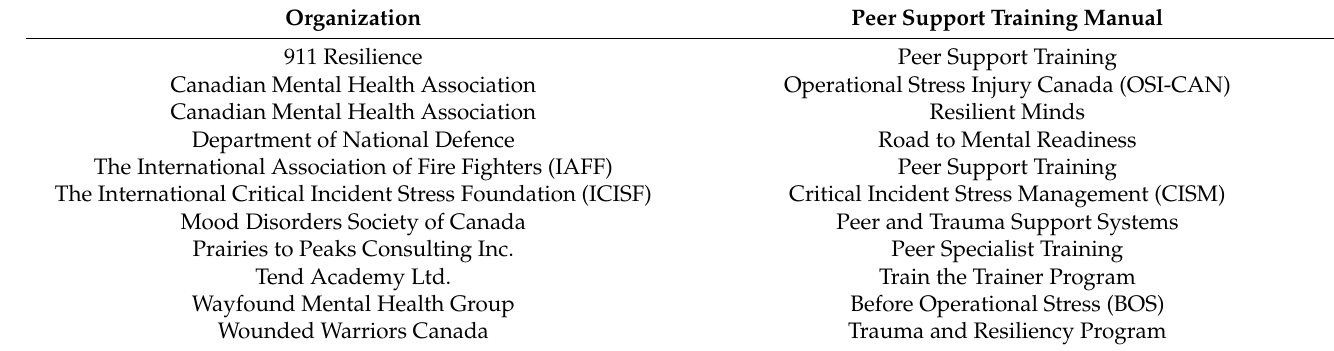
Table 1. List of participating organizations and their respective peer support